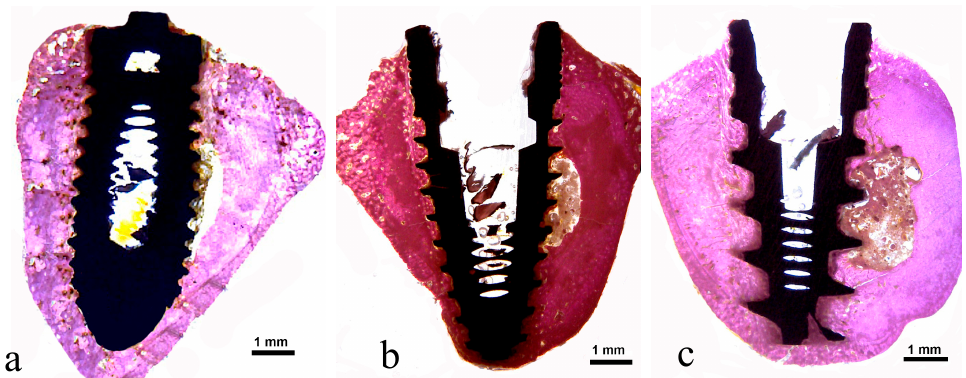
Figure 5. Representative histological images of samples: ( a ) Group 1, ( b ) Group 2, and ( c ) Group 3. In the central portion of the implants corresponding to side 2 (bone marrow tissue), as shown in the scheme of Figure 4, different levels of bone formation were observed in the three groups. A thin layer of newly formed bone tissue was interposed on the surface of the implant in this area in G2 and G3, while in G1 a few signs of neoformation were found (Figure 6).